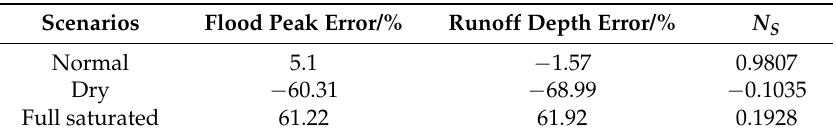
Table 3. Error statistics of calculation results using different initial state variables.